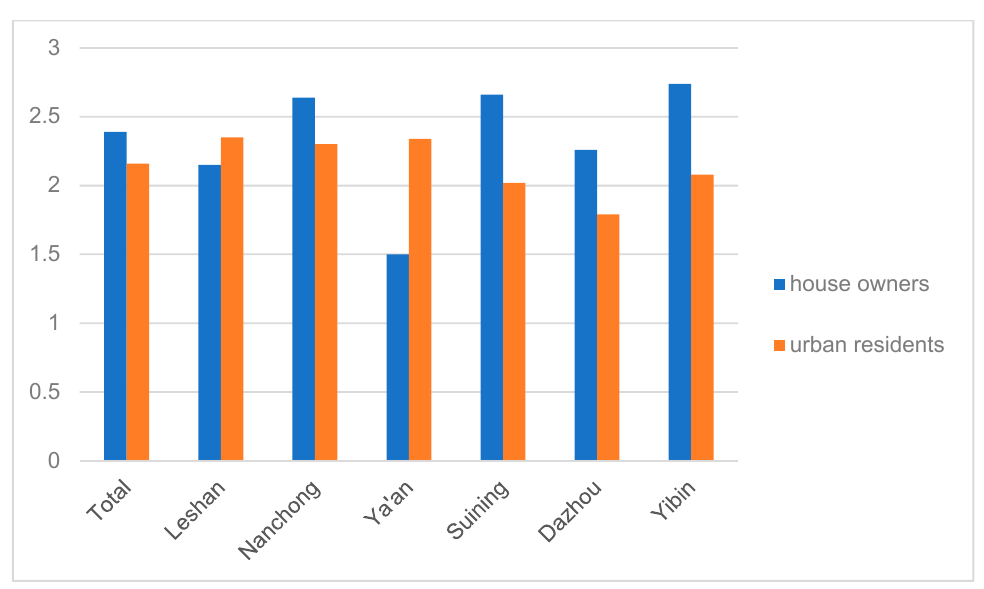
Figure 4. Matching analysis between house owners’ willingness and urban residents’ willingness.